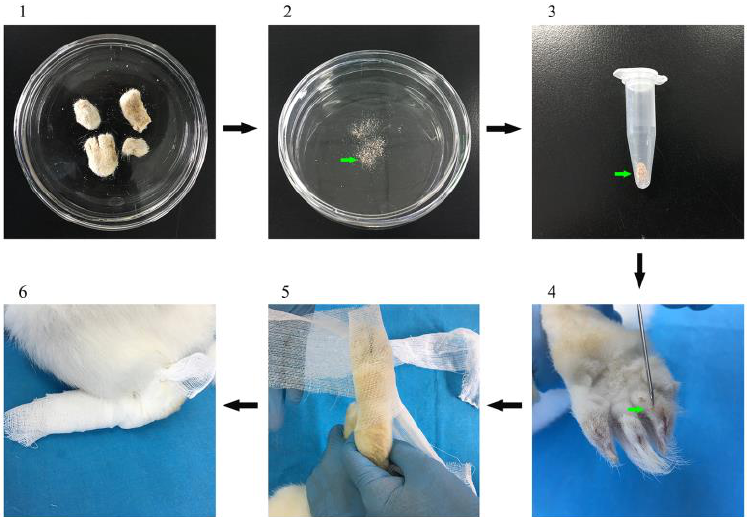
Figure 1. The collection of S. scabiei and mite challenge. ( 1 ) The skin scrapings from euthanized rabbits were collected and incubated at 38 ◦ C; ( 2 ) the mites were counted after a 2-h incubation; ( 3 ) the mites were collected into a pipe; ( 4 – 6 ): rabbits were challenged via the two hind